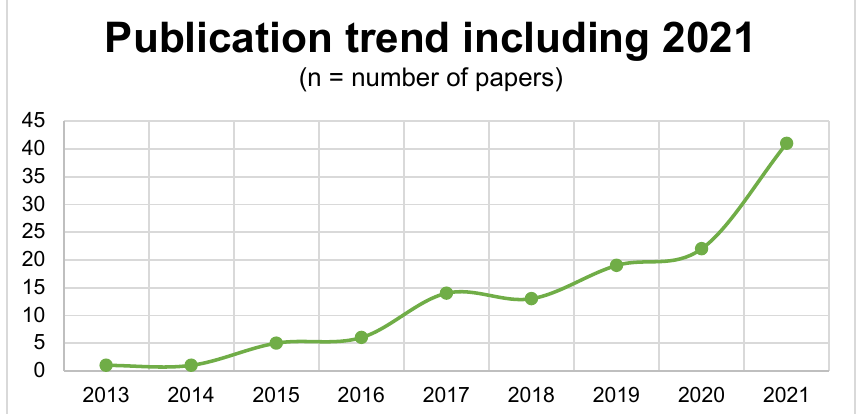
Figure 1. Number of publications relating to 3D printing in upper extremity surgery by year. In PubMed , the following search query was used: (“3D” OR “3 ‐ dimensional”) AND “print*” AND (“upper extremity” OR “upper limb”).